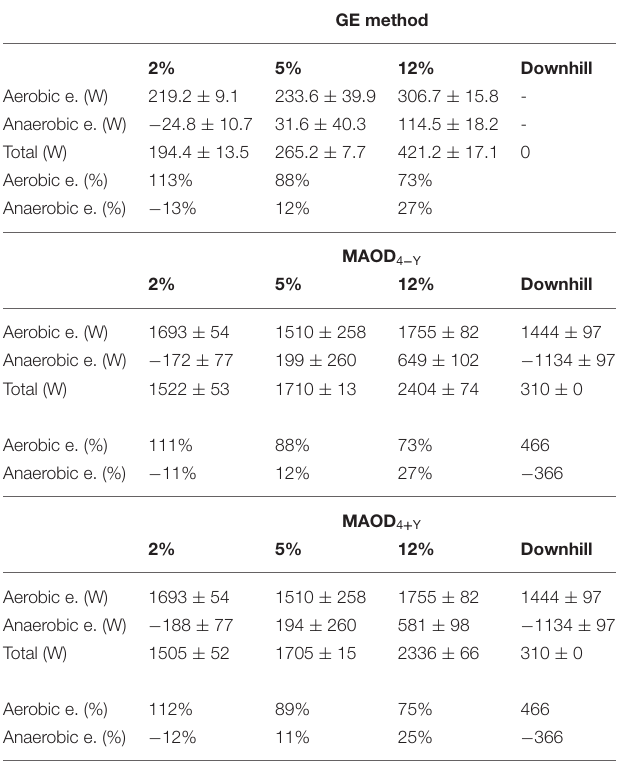
TABLE 3 | The average aerobic and anaerobic energy contributions on the relatively flat segment (2%), moderate incline (5%), steep incline (12%), and simulated downhill